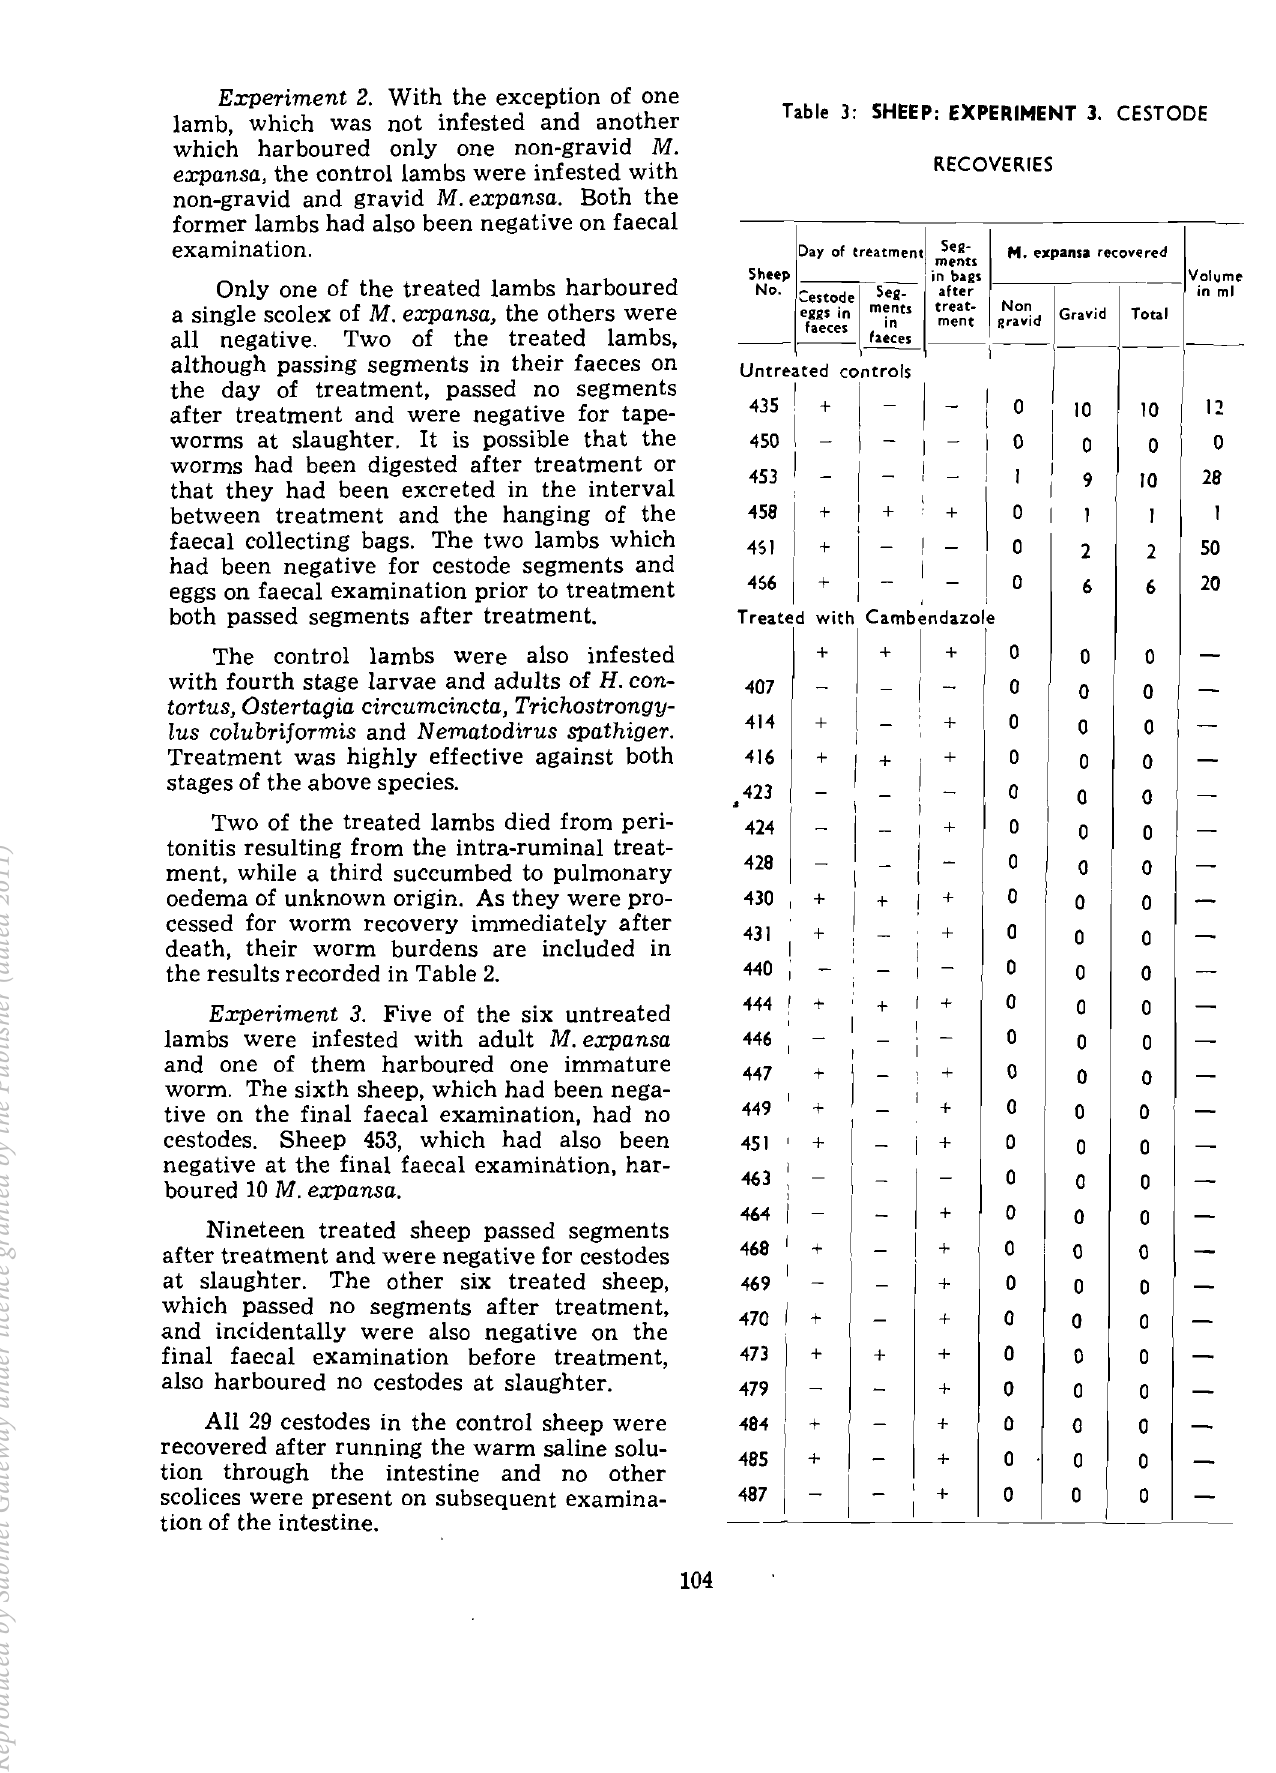
Day of tr.atmentl I